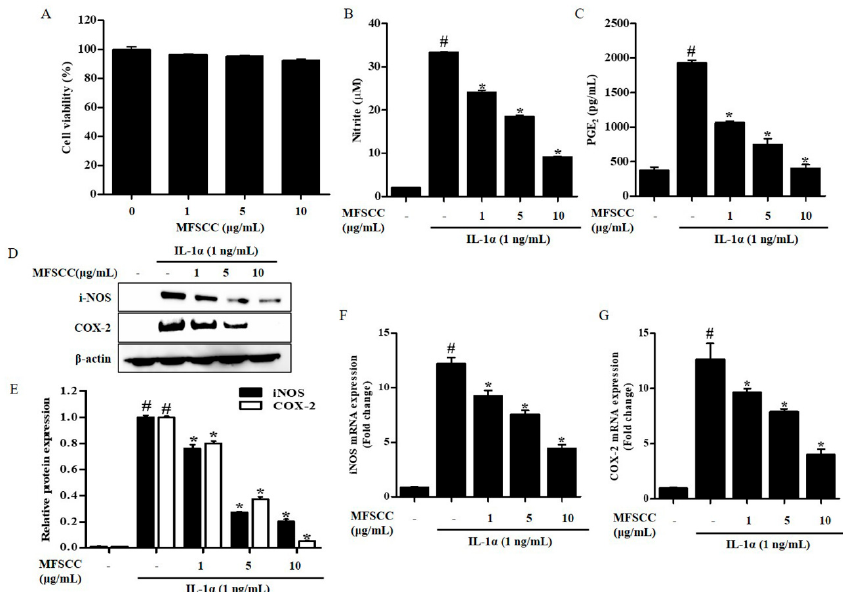
Figure 1. E ff ect of MFSCC on cell viability and inflammation in rat primary chondrocytes. ( A ) The cytotoxic e ff ects of MFSCC were examined by CCK-8 assay and cell cultures were treated with di ff erent concentrations of MFSCC (0, 1, 5, and 10 µ g / mL) for 24 h. The MFSCC showed no cytotoxicity in rat primary chondrocytes. The results are indicated as mean ± SEM (* p < 0.05 compared with the